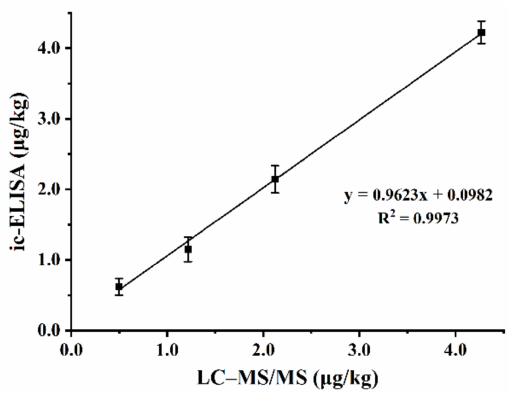
Figure 6. Correlation of LC–MS/MS and ic-ELISA for the analysis of spiked chicken